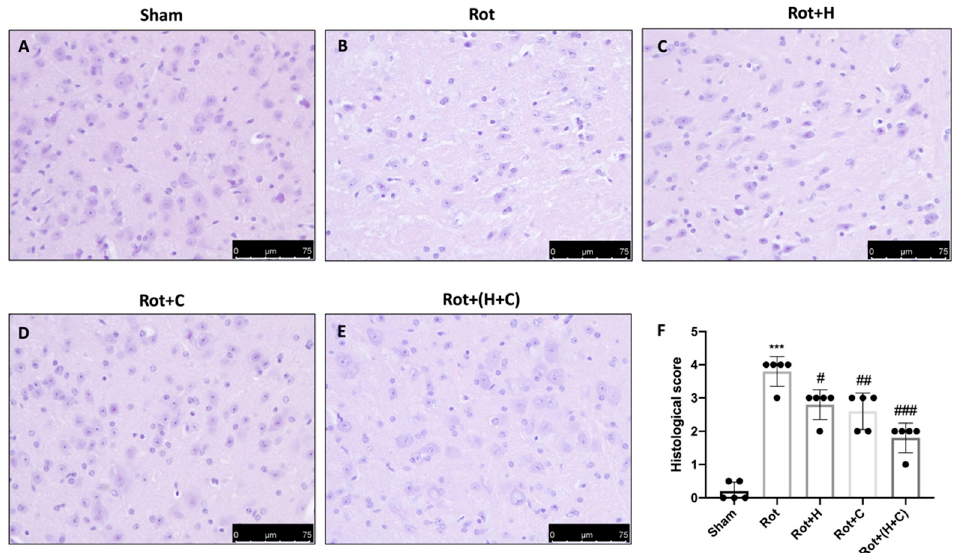
Figure 6. Effect of H or C or H+C on histological parameters in Rot-lesioned mice. Rot-injured mice